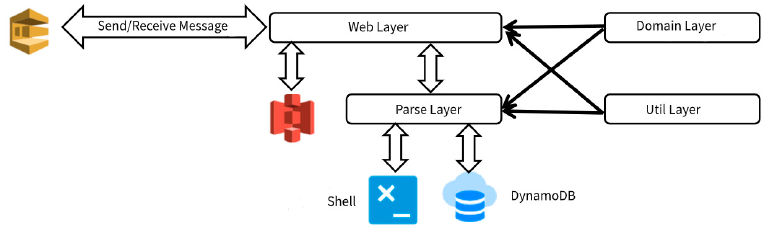
Figure 11. Background Structure.